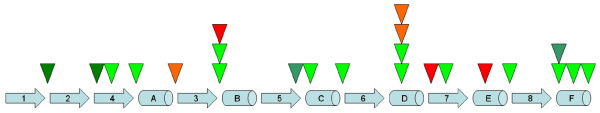
Position and number of RCRRs, projected on a linear representation of the α/β fold. α-helices and β-strands are depicted as cylinders and arrows, respectively, the linking loops are not shown. Predicted RCRRs are represented by coloured triangles. Each triangle represents a RCRR in one distinct homologous protein family. Triangles are coloured by the respective window score W (light green 1.8 ≤ W ≤ 2.7, dark green 2.8 ≤ W ≤ 3.7, orange 3.8 ≤ W ≤ 4.7, red 4.8 ≤ W).